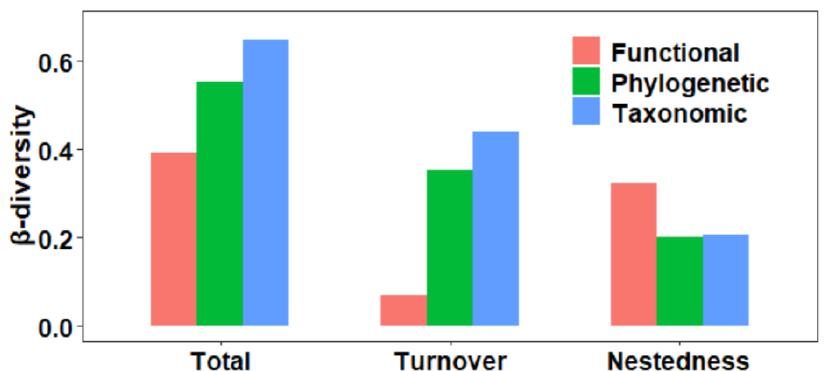
Figure 1. The three facets (taxonomic, functional, and phylogenetic) of macroinvertebrates’ β -diversity and its components (i.e., total, turnover, and nestedness) in the Hun-Tai River Basin.